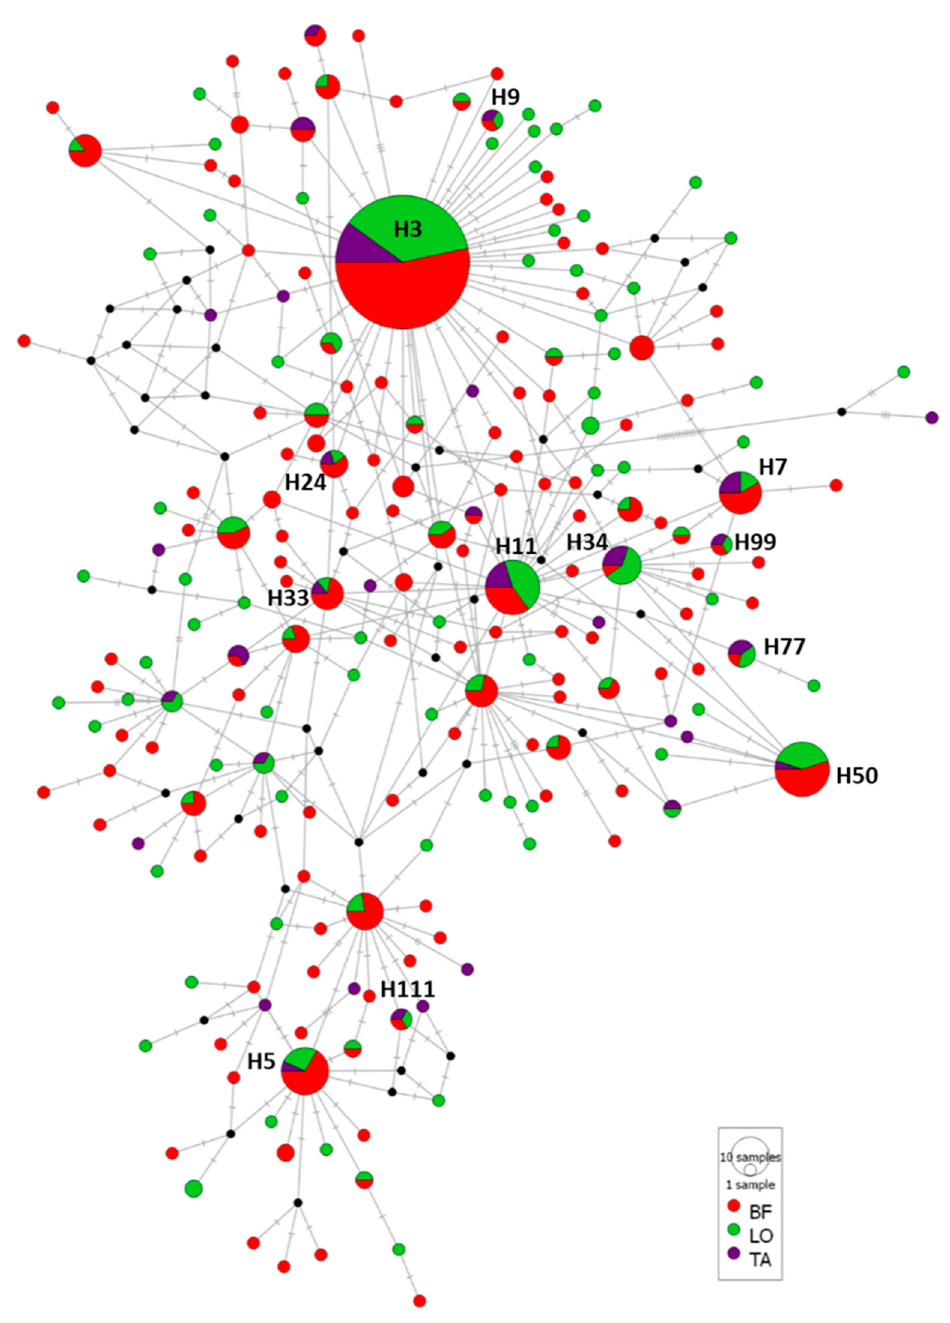
Figure 3. Median-joining haplotype network of A. simplex mtDNA cox2 sequences obtained of muscular sections from European hake: belly flaps (BF), loins (LO) and tails (TA). Circles’ size represents the frequency of each haplotype. Hatch marks show the number of mutations distinguishing the haplotypes. Haplotypes shared for the three sections are reported. Black points indicate missing haplotypes.